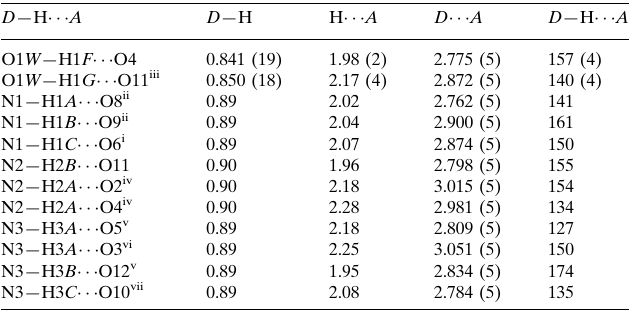
Hydrogen-bond geometry (A˚ , (cid:3)